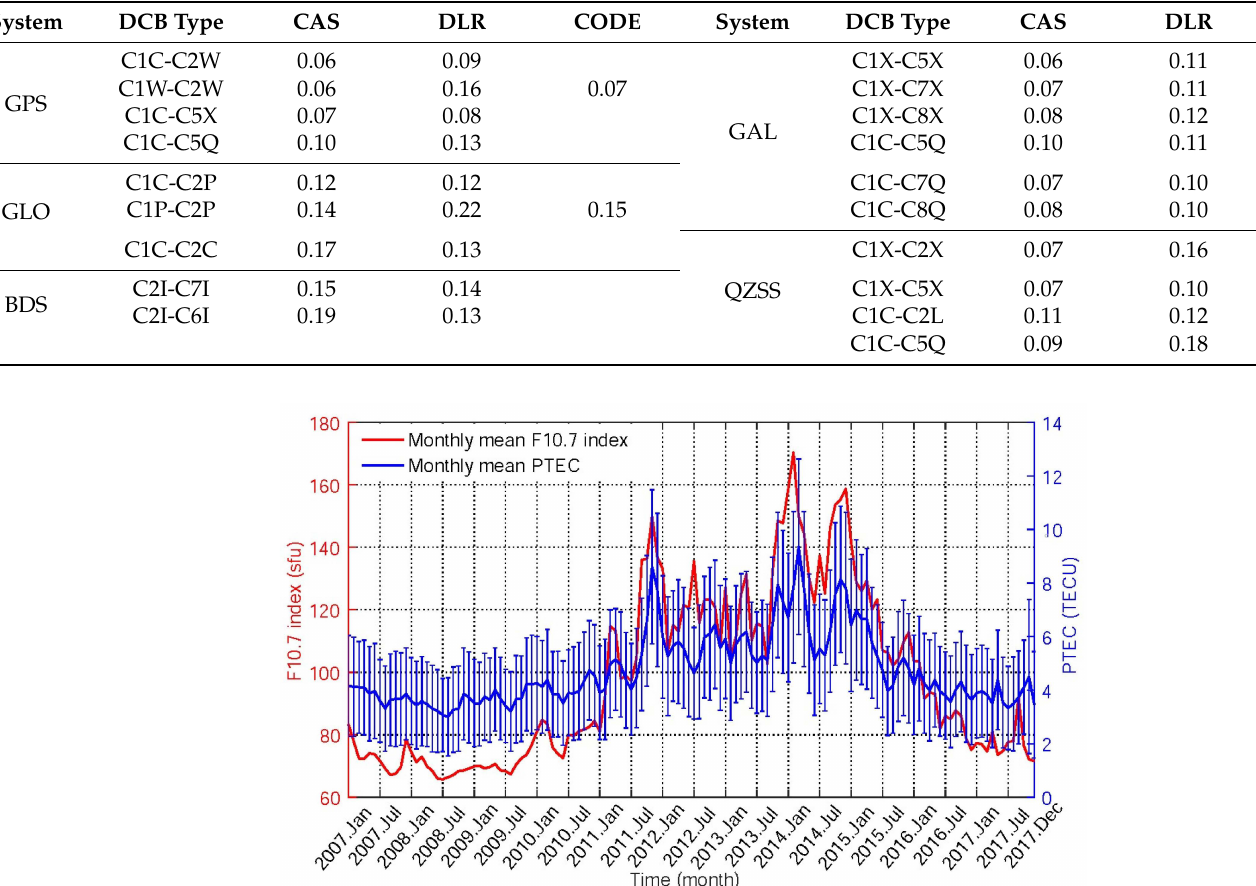
Table 4. The mean RMS of estimated satellite DCB relative to the DCB product provided by MGEX.